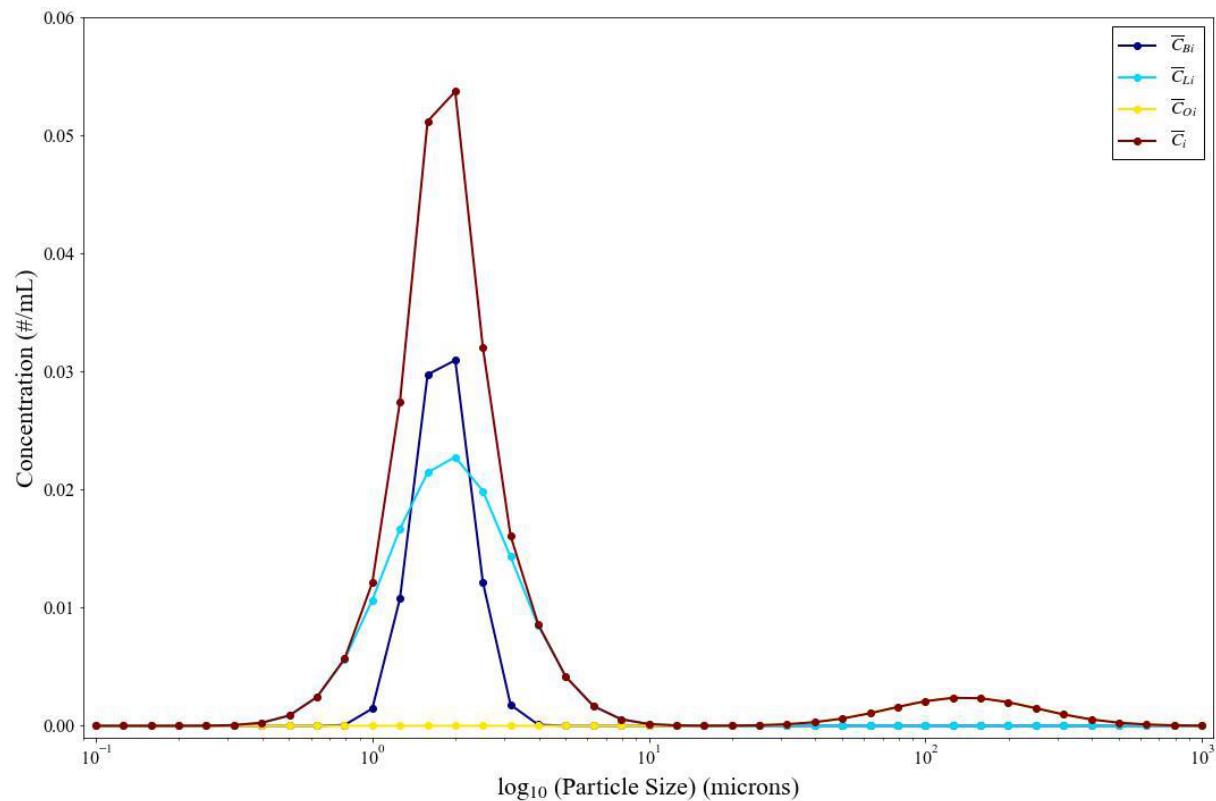
Figure 3 . Contribution of emission route to the total particle concentration for coughing.